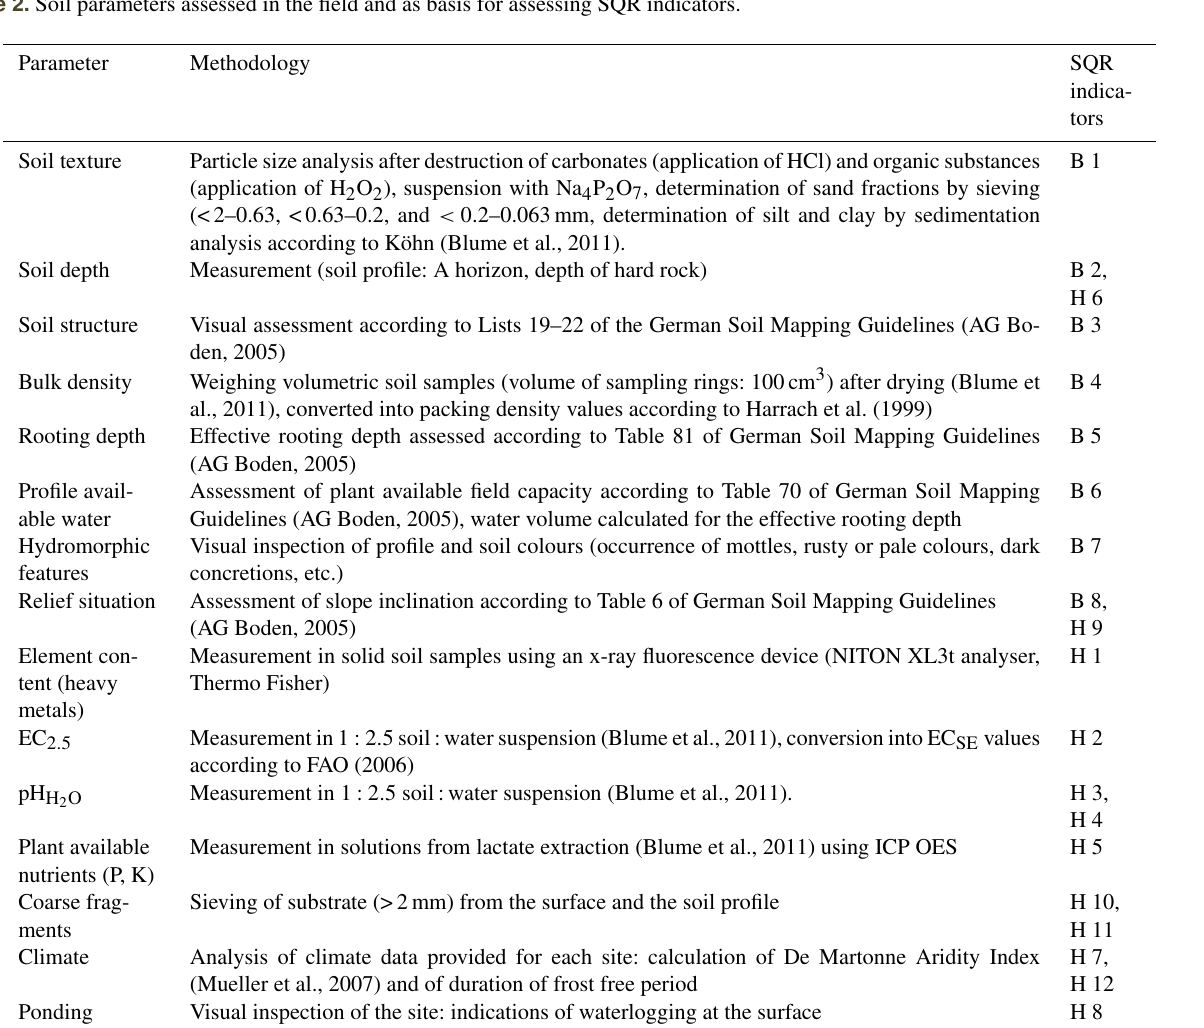
Analysis of climate data provided for each site: calculation of De Martonne Aridity Index (Mueller et al., 2007) and of duration of frost free period Visual inspection of the site: indications of waterlogging at the